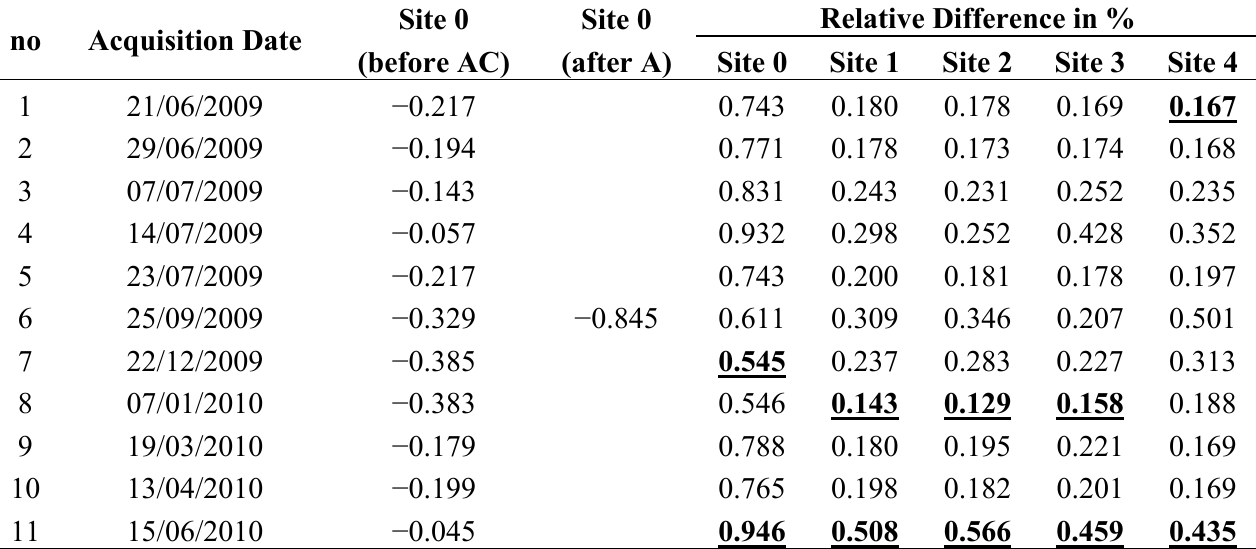
Table 9. Relative NDVI differences for all sites, before and after atmospheric correction (min and max values for each site are underlined).